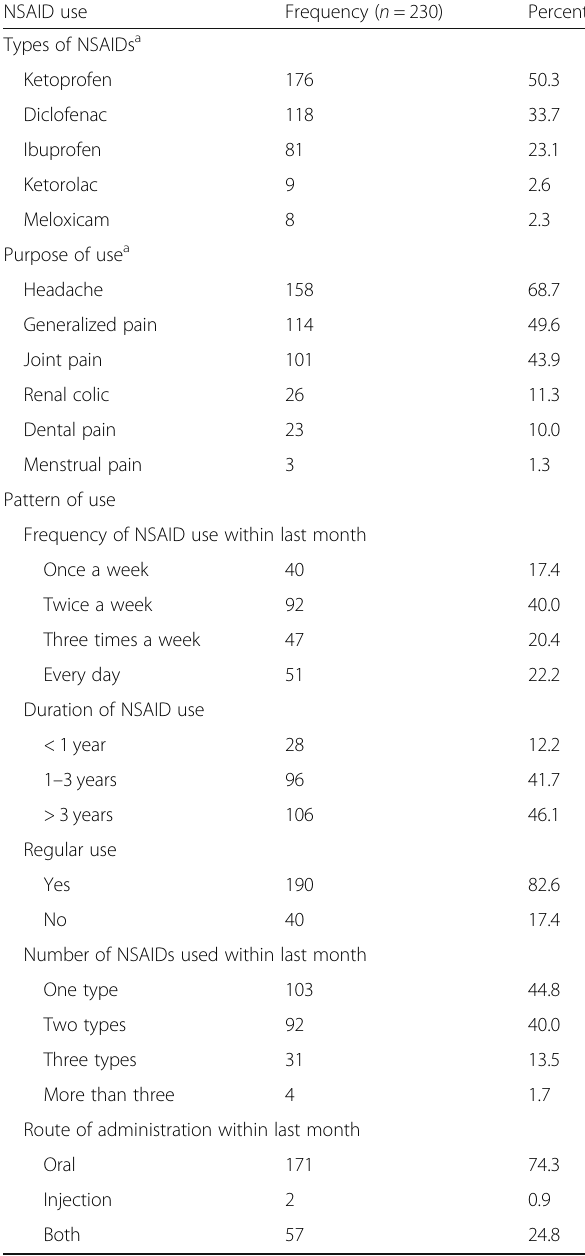
Table 2 NSAID use by the study CKD patients (Alexandria Main University Hospital, Egypt,